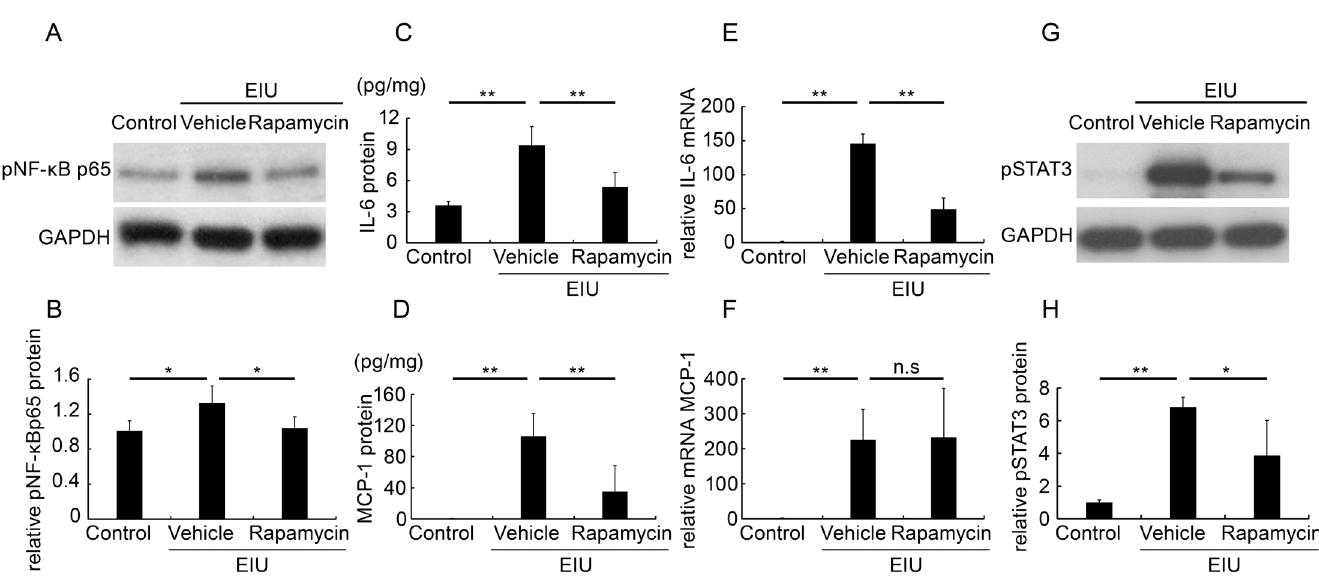
Fig 3. Rapamycin suppressed inflammatory molecules in the retina during inflammation. Immunoblot analysis showed that phosphorylated nuclear factor kappa-light-chain-enhancer of activated B cells p65 (pNF- κ Bp65) was increased in the retina 3 hours after the induction of inflammation by an intraperitoneal injection of lipopolysaccharide (LPS), and that this was attenuated by the rapamycin treatment (A, B). ELISA assays showed that the protein levels of interleukin-6 (IL-6) and monocyte chemoattractant protein-1 (MCP-1) were increased in the retina 12 hours after the induction of inflammation, and that these changes were attenuated by the rapamycin treatment (C, D). Real-time PCR showed that the mRNA levels of both IL-6 and MCP-1 were increased 6 hours after the induction of inflammation, and that the mRNA level of IL-6 (E), but not that of MCP-1 (F), was attenuated by the rapamycin treatment. Immunoblot analyses showed that the expression level of phosphorylated and activated signal transducer and activator of transcription 3 (pSTAT3) was increased at 12 hours after inflammation, and that this increase was attenuated by the rapamycin treatment (G, H); n = 5. * p < 0.05, ** p <